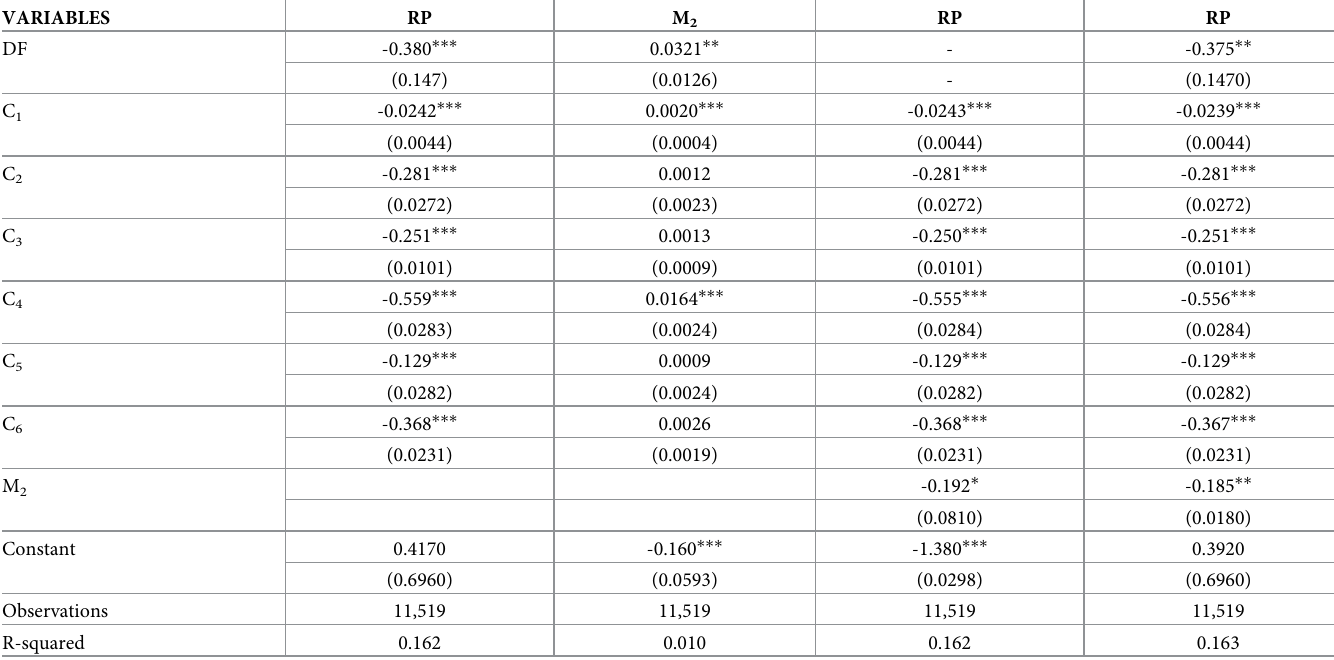
Table 9. Robustness test of the mediation effect of financial asset allocation.